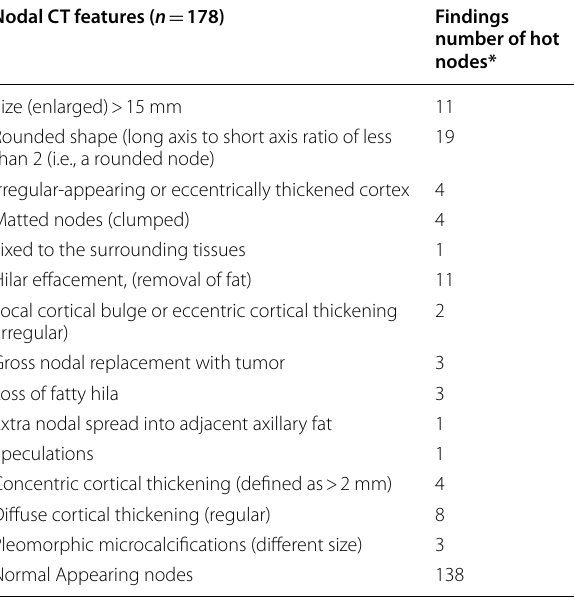
Table 1 Characterization of morphological features of axillary lymph nodes on